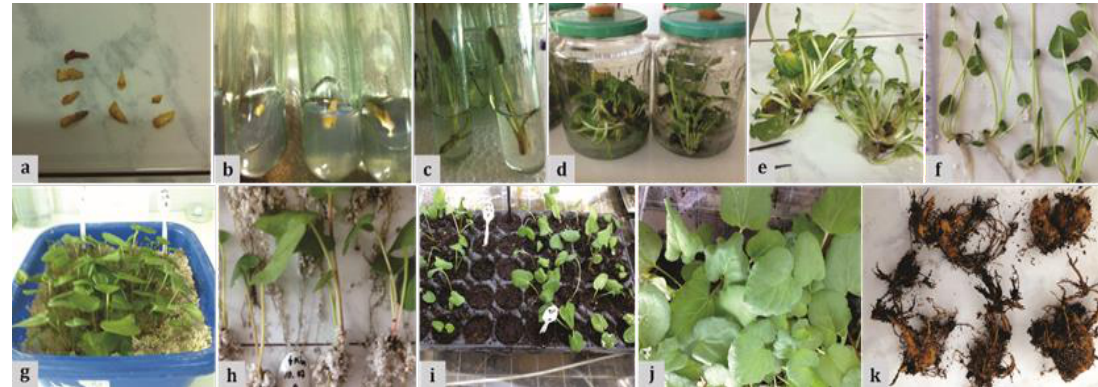
Figure 1. In vitro propagation of Rheum rhabarbarum L.: ( a – c ) In vitro culture initiation; ( d,e ) Multiplication stage on the medium MSm + 4 mg L −1 BA; ( f ) in vitro rooted plantlets on hormone-free MSm; ( g – j ) Acclimatization stage; ( k ) Tissue cultured rhubarb rhizomes.